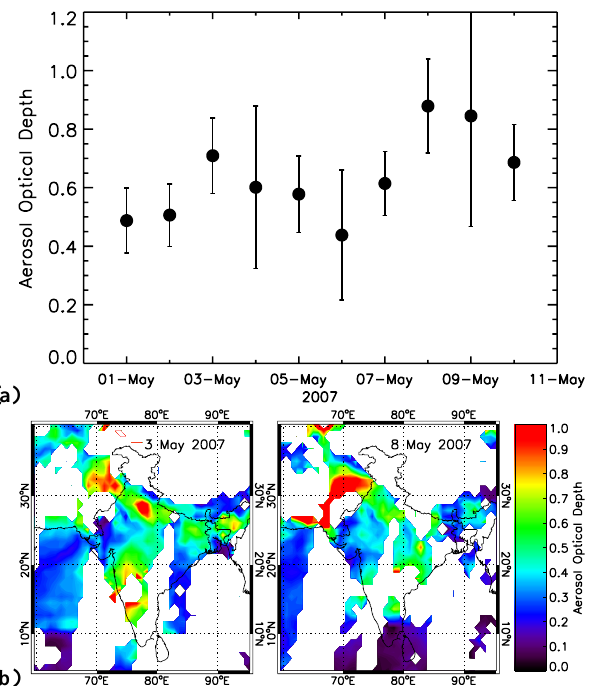
Fig. 1. (a) Day-to-day variation and (b) spatial distribution of AOD over Thar Desert (latitudes: 20–30 ◦ N, longitudes: 60–80 ◦ E) as observed by MODIS-Terra satellite.